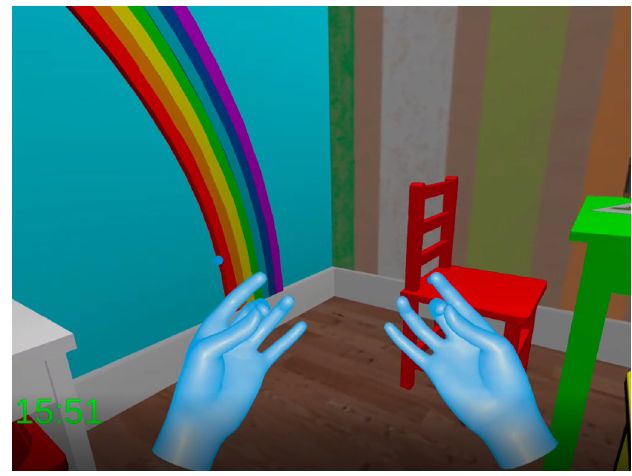
Figure 1. Pinch gesture. The middle finger is touching the thumb at both hands